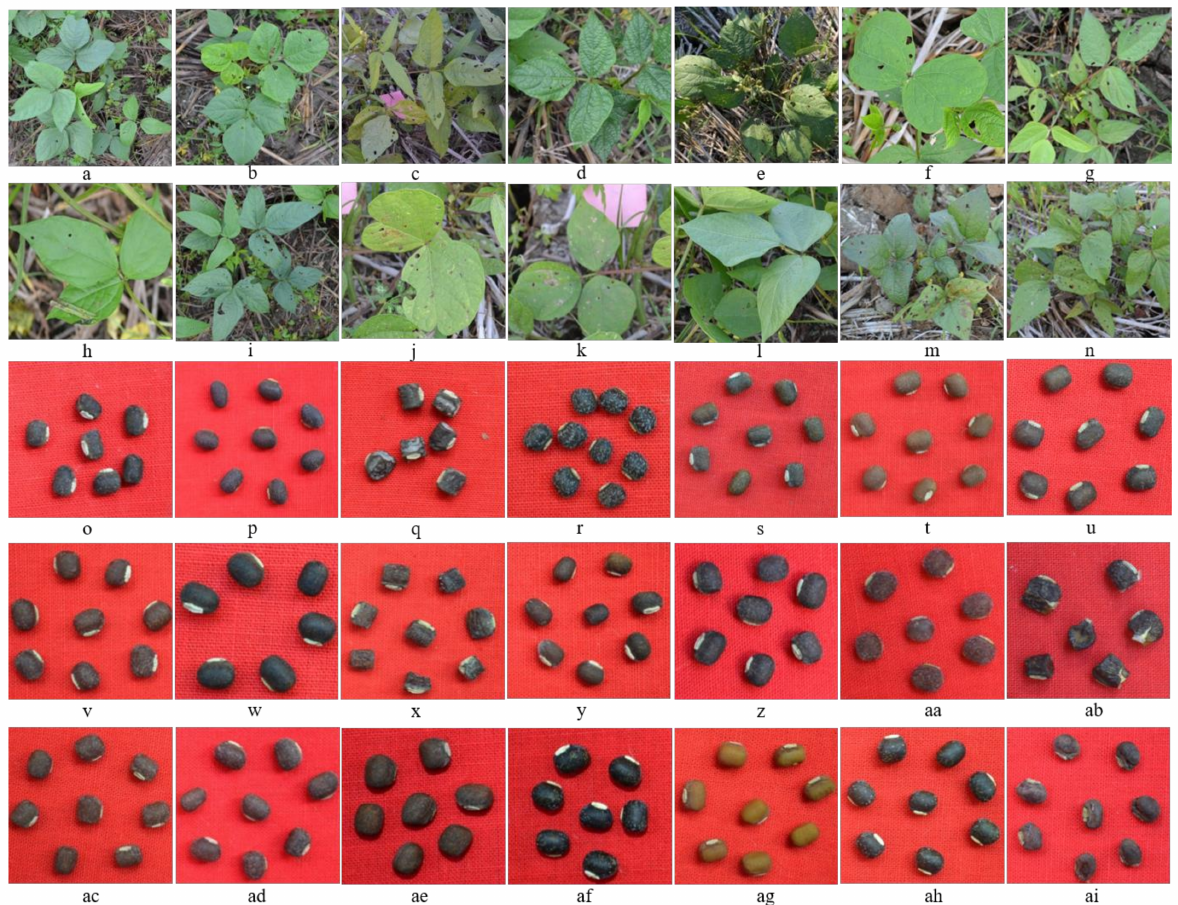
Figure 2. Variation observed in leaf and seed characteristics of cv. ADT 3, Co 6, and TU 17-9 mutagenized populations. ( a ) cv. ADT 3 (wild); ( b – g ) leaf variations in cv. ADT 3 mutagenized population. ( h ) cv. Co 6 (wild); ( i , j ) leaf variation in cv. Co 6 mutagenized population. ( k ) cv. TU 17-9 (wild); ( l – m ) leaf variations in cv. TU 17-9 mutagenized population. ( o ) cv. ADT 3 (wild); ( p – u ) seed characteristic variations in cv. ADT 3 mutagenized population. ( v ) cv. Co 6 (wild); ( w – ab ) seed characteristic variations in cv. Co 6 mutagenized population. ( ac ) cv. TU 17-9 (wild); ( ad – ai ) seed characteristic variations in cv. TU 17-9 mutagenized